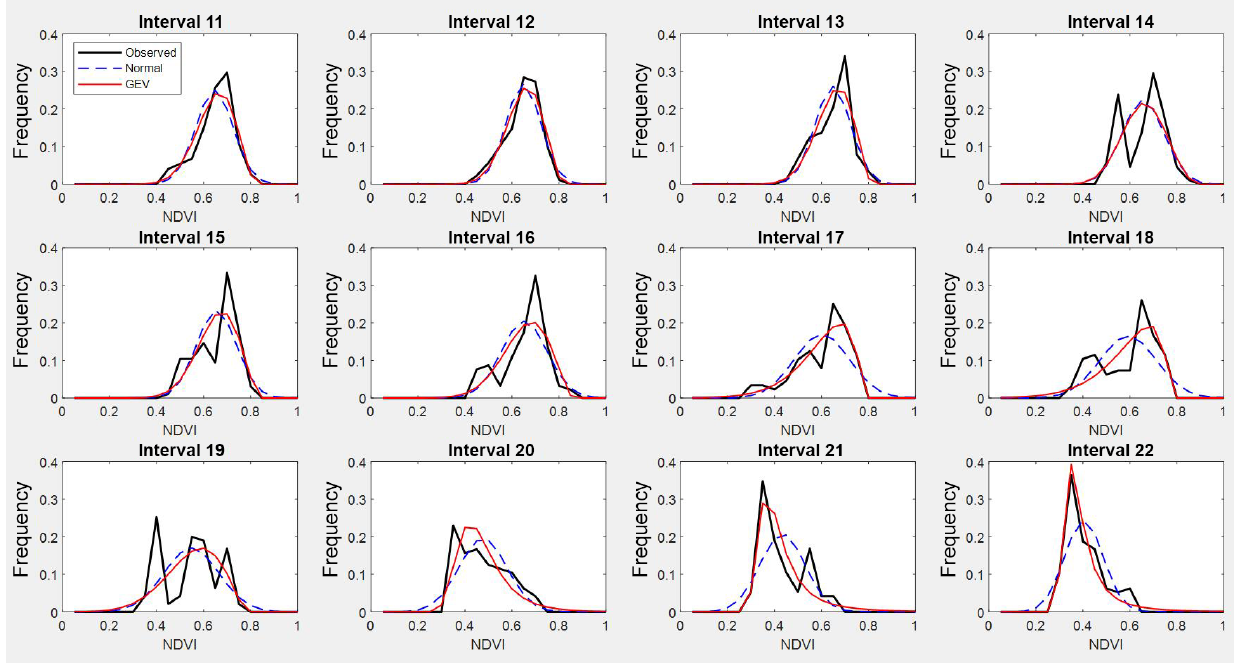
Figure A2. Observed NDVI, GEV and normal probability density functions from interval 11 to interval 22 (from 22 March to 25 June) representing spring.